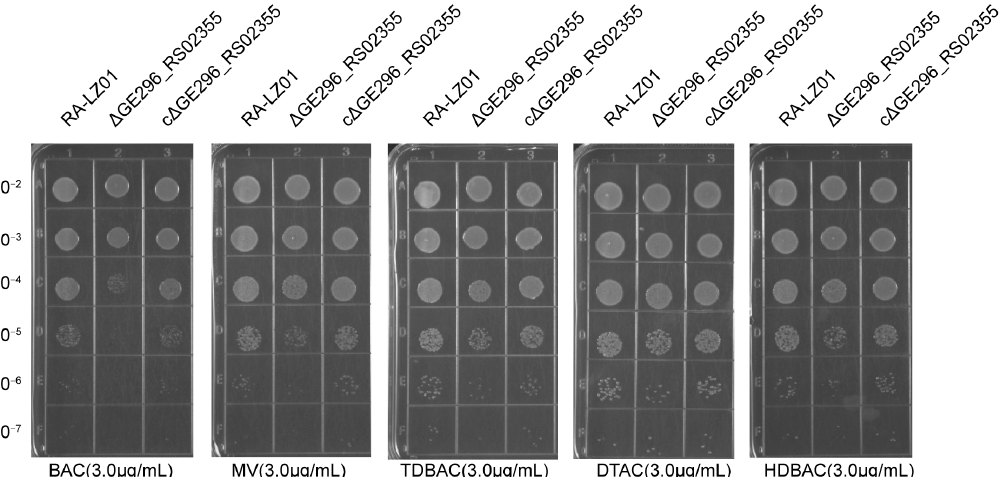
Figure 2. Comparative analyses of QACs resistance in parent strain RA-LZ01 and mutant strain. Growth of parent strain RA-LZ01, deletion strain RA-LZ01 Δ ranQ , and complemented strain RA-LZ01c Δ RanQ were determined by spot assay on TSA plates containing the same concentration of QACs. Remarkably, the deletion strains were grown on TSA plates including 5% calf serum, and a signi fi cant di ff erence was observed in the presence of BAC and MV. A representative result is given from the three independent experiments.